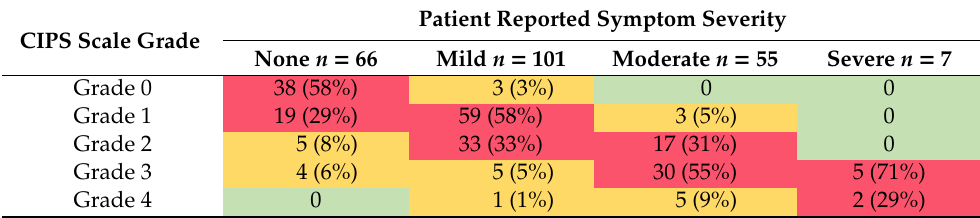
Table 3. Patient reported symptom severity compared with CIPS